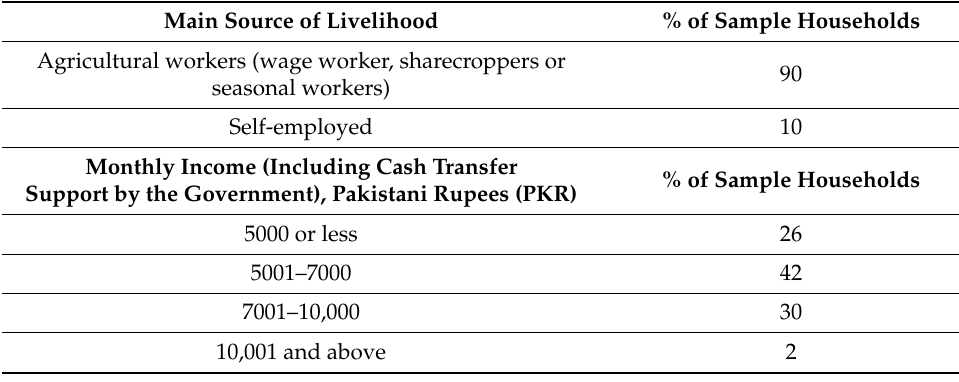
Table 2. Socio- economic profile and monthly income of sample